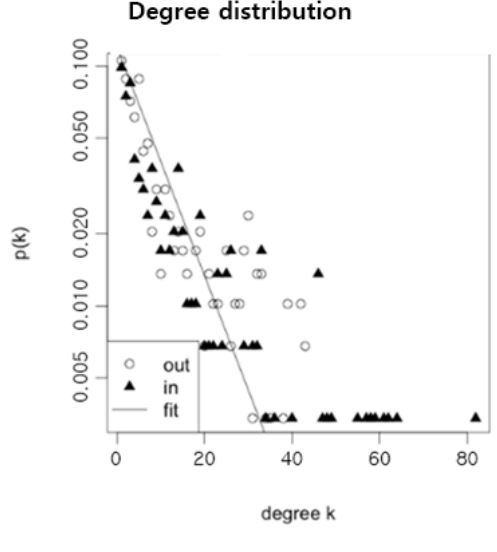
Figure 2. Distribution of the network for in- and out-degrees.